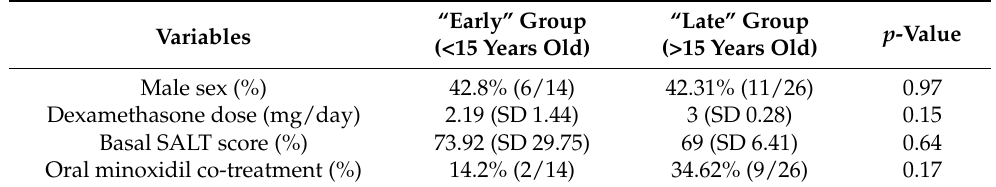
Table 2. Basal characteristics in “early” and “late” onset groups. No differences were found between groups in any of the variables analyzed.